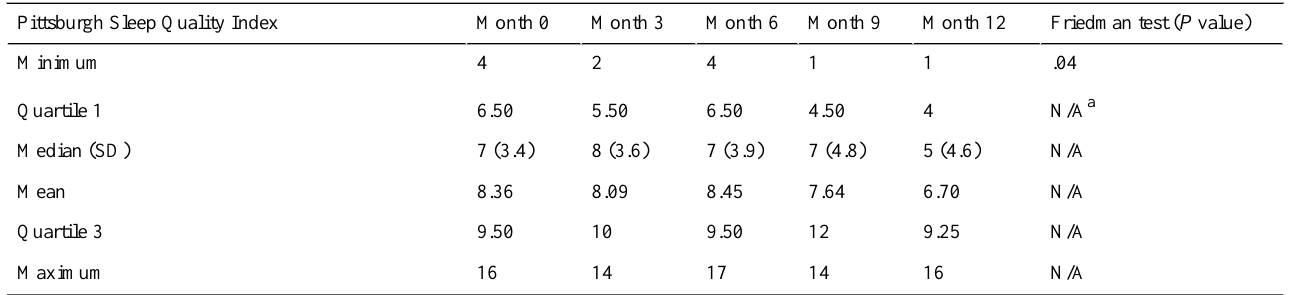
Table 15. Informal caregivers’Pittsburgh Sleep Quality Index score during the year progression.